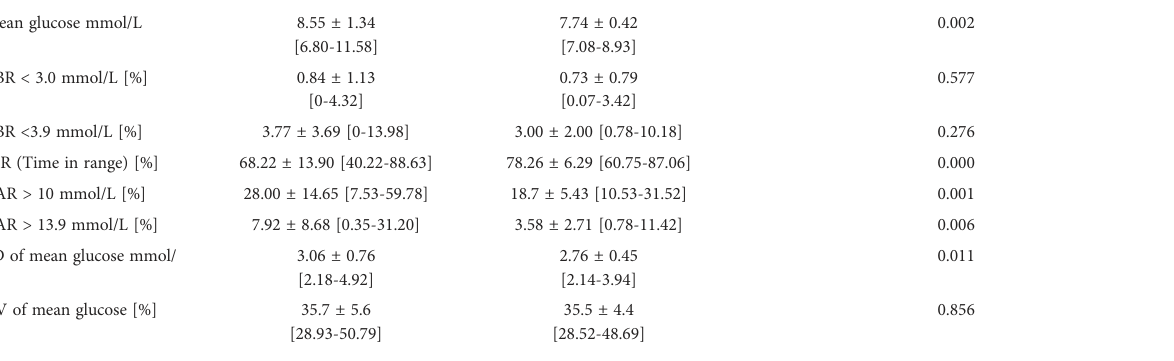
TABLE 7 Clinical and glycemic